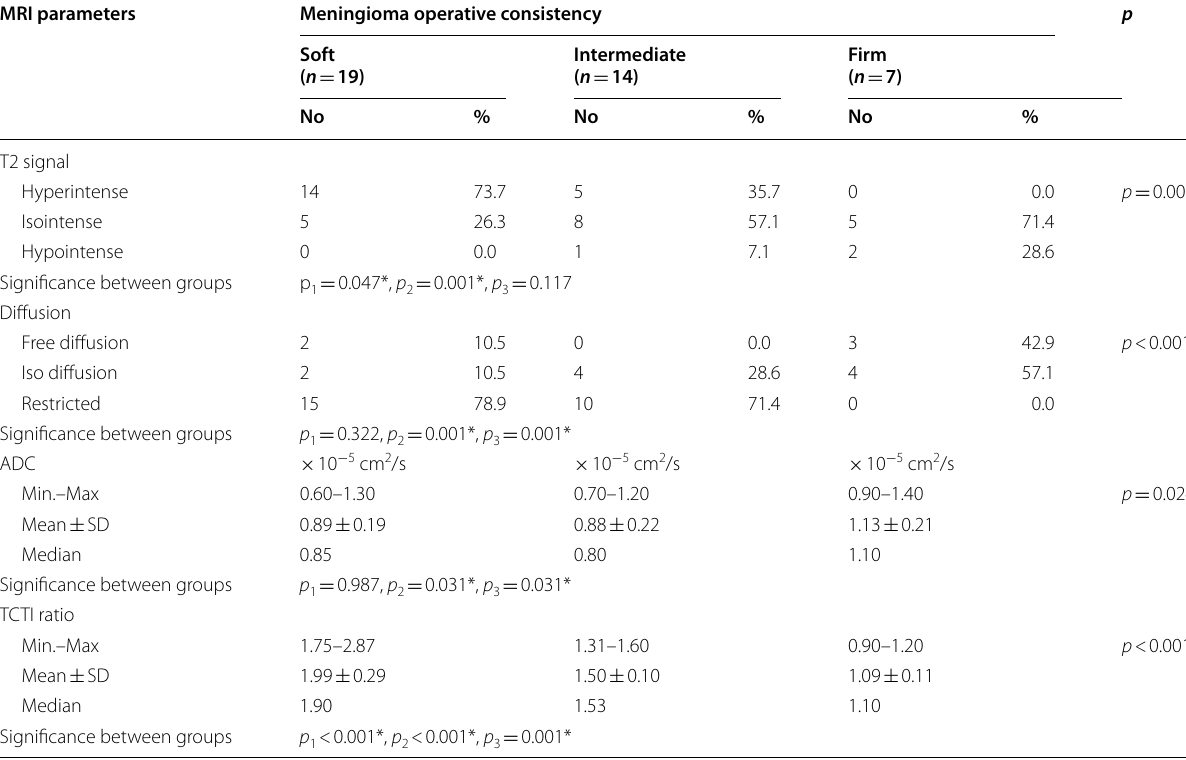
ADC, apparent diffusion coefficient; p , p value for association between different categories; n, number of patients; p 1 , p value for association between soft and intermediate; p 2 , p value for association between soft and firm; p 3 , p value for association between intermediate and firm; SD, standard deviation; TCTI, Tumor/ cerebellar peduncle T2-weighted imaging intensity